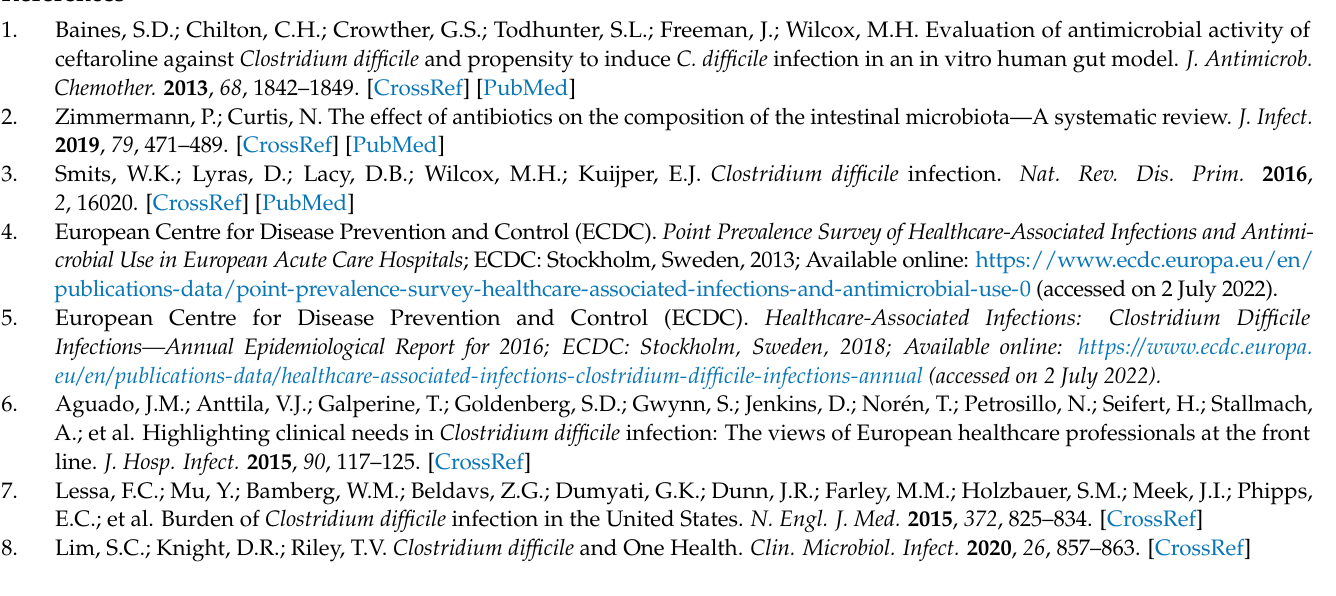
Figure S3: Effect of ciprofloxacin (CIP, 139 mg/L, 12-hourly) on C. difficile strains, NTCD-E4 and RT027, total viable counts (TVC), spore counts (SP), and cytotoxin titres in a human gut model (Vessel 3, pH 6.8). Figure S4: Effect of cefotaxime (CFX, 20 mg/L, 12-hourly) on C. difficile strains, NTCD-E4 and RT027, total viable counts (TVC), spore counts (SP), and cytotoxin titres (CYT) in a human gut model (Vessel 3, pH